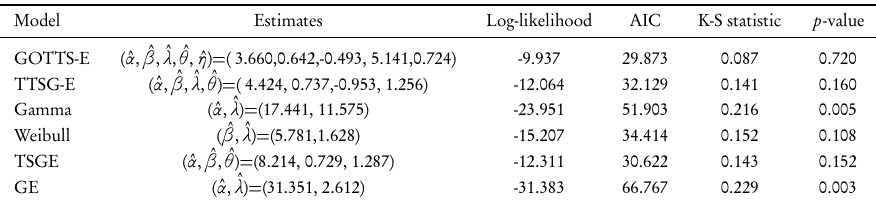
The MLE’s of parameters for the second data